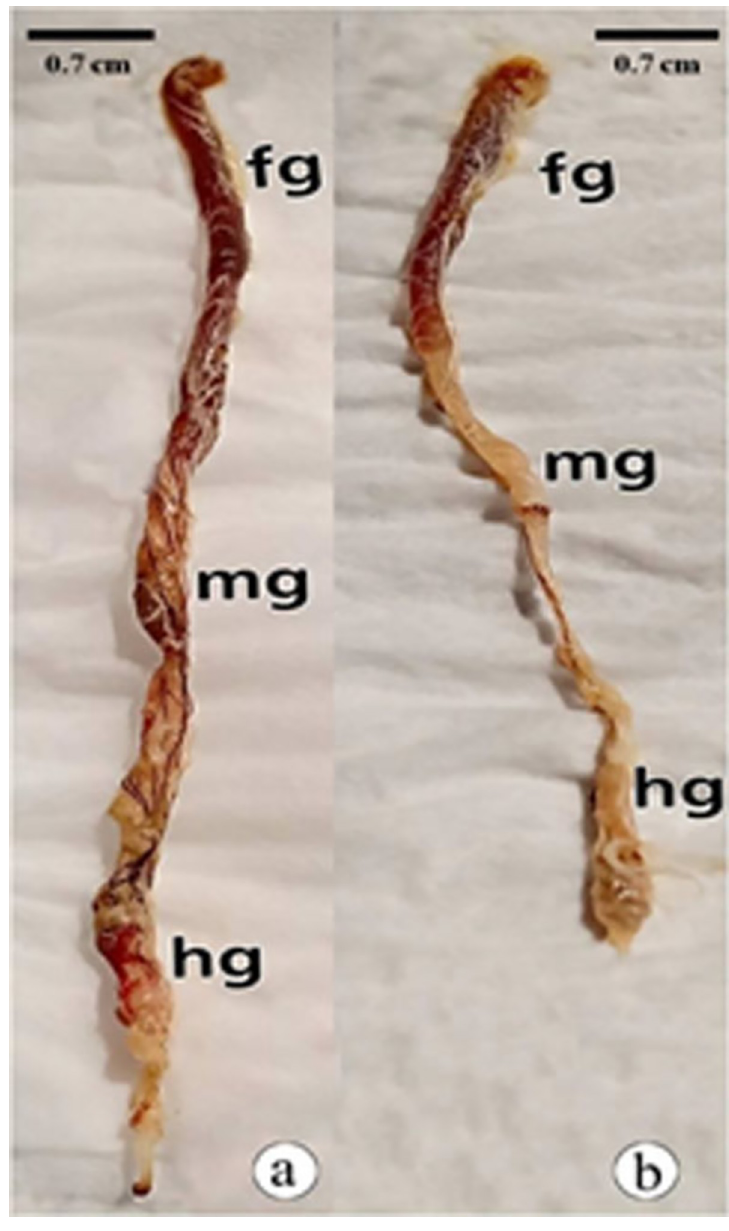
Fig 4. Photograph of the alimentary canal of B . polychresta , a: Untreated group b: Treated group. fg: foregut, mg: midgut, hg: hindgut.